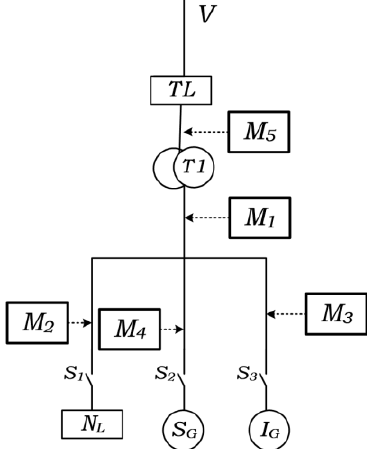
Fig. 4. Interconnected electrical power system - IEPS for Case Study 1.